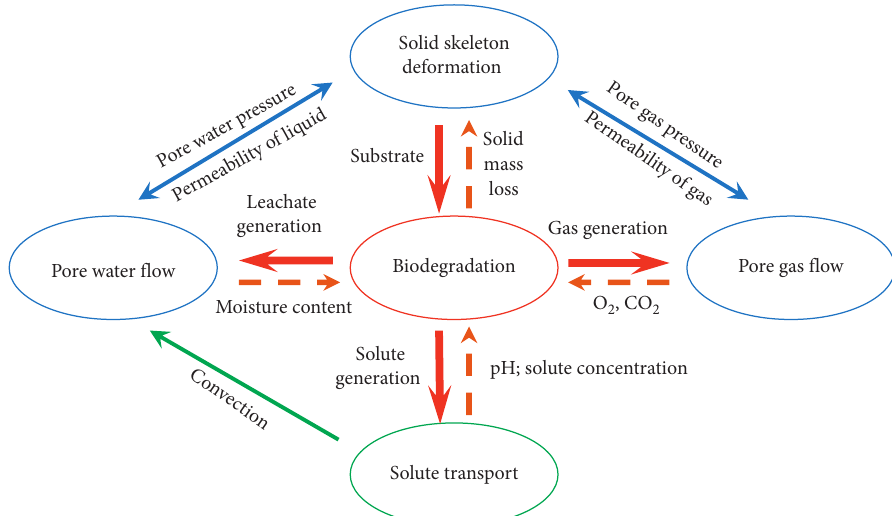
Figure 1: Biodegradation-hydraulic-mechanical coupled behaviors in landfilled